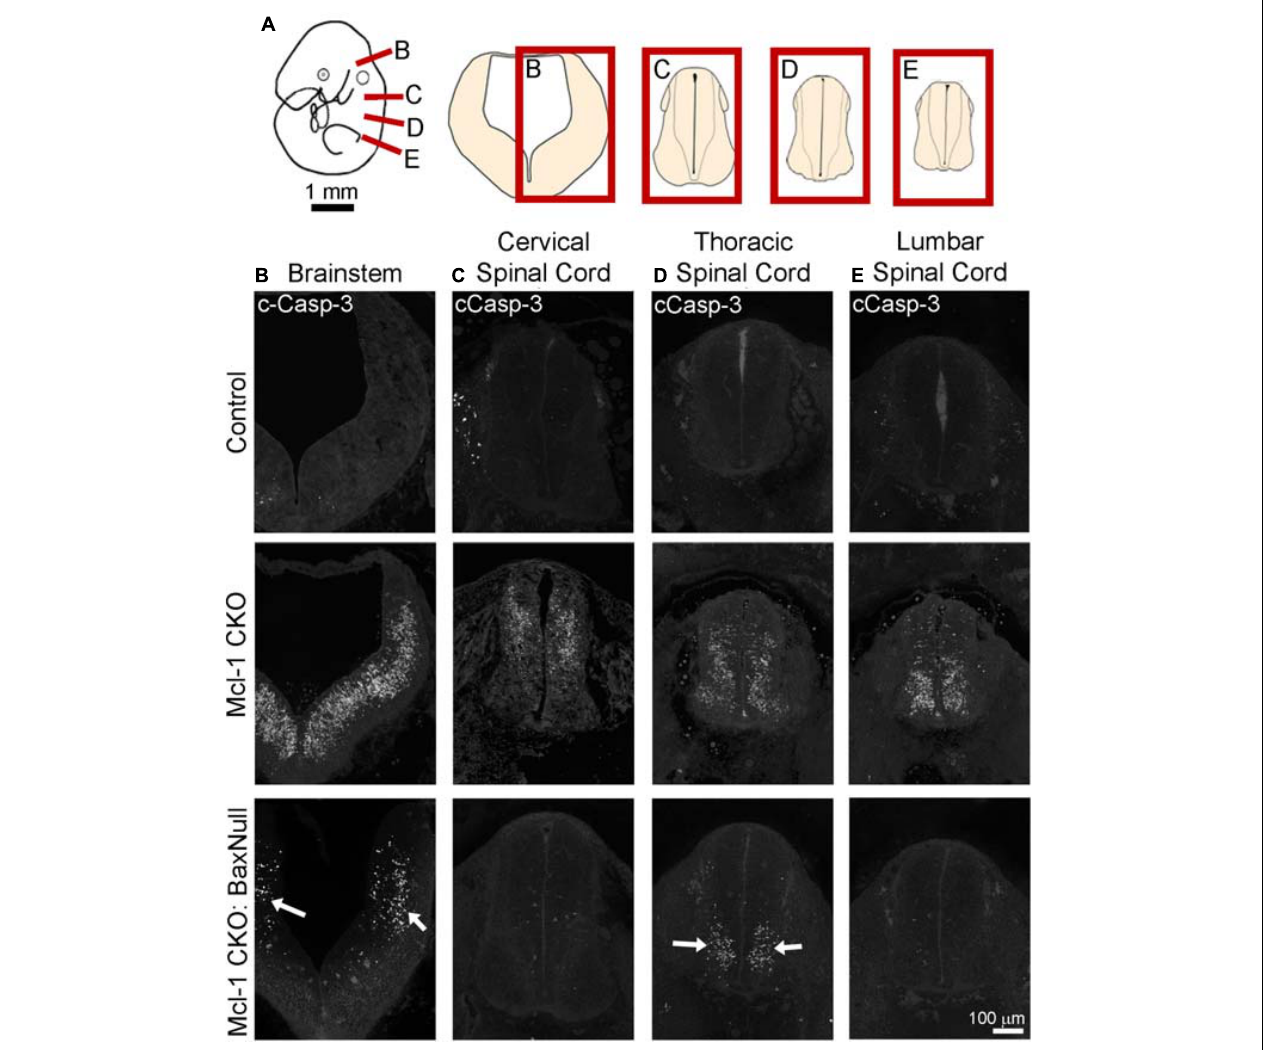
FIGURE 6 | Co-deletion of Mcl-1 and Bax does not rescue all NPC from apoptotic cell death in the developing nervous system at E11. (A) Diagram of an E11 embryo showing the levels of brainstem and spinal cord. Representative sections of cCasp-3 immunohistochemistry (white) at the level of the (B) brainstem, (C) cervical spinal cord, (D) thoracic spinal cord, and (E) lumbar spinal cord of CTL ( n = 4), Mcl-1 CKO ( n = 4) and Mcl-1 CKO/BaxNull ( n = 3). Arrows point to apoptotic cells in Mcl-1 CKO/BaxNull